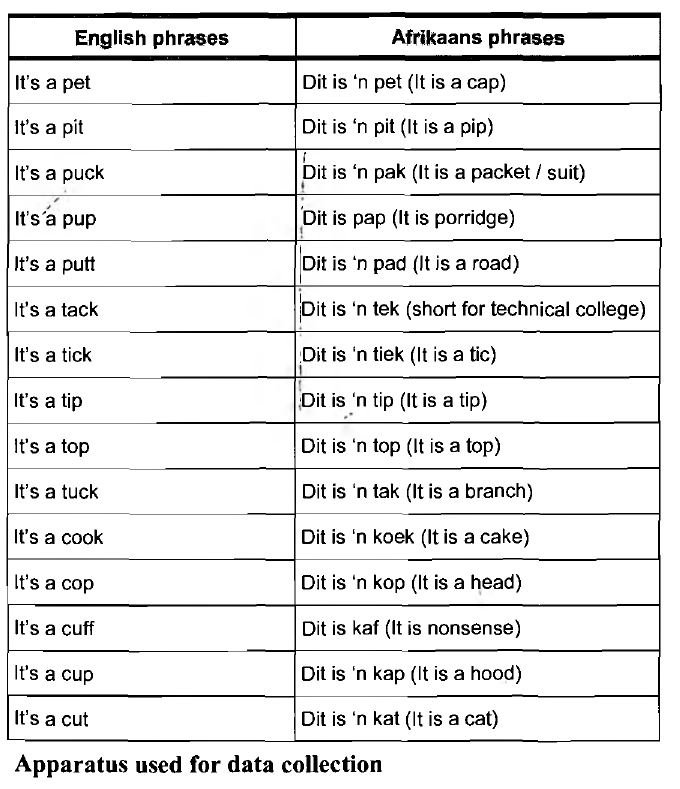
Table 2: Target phrases used in data